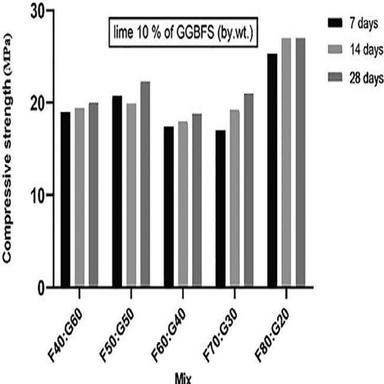
Compressive strength of FCA based geopolymer with GGBFS and lime.